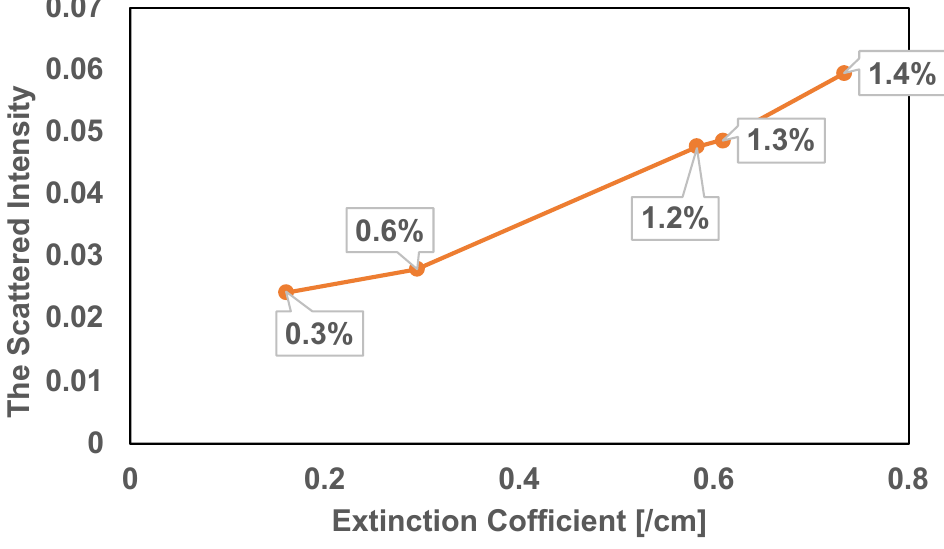
Figure 9. The relationship between the extinction coefficient and the scattered light